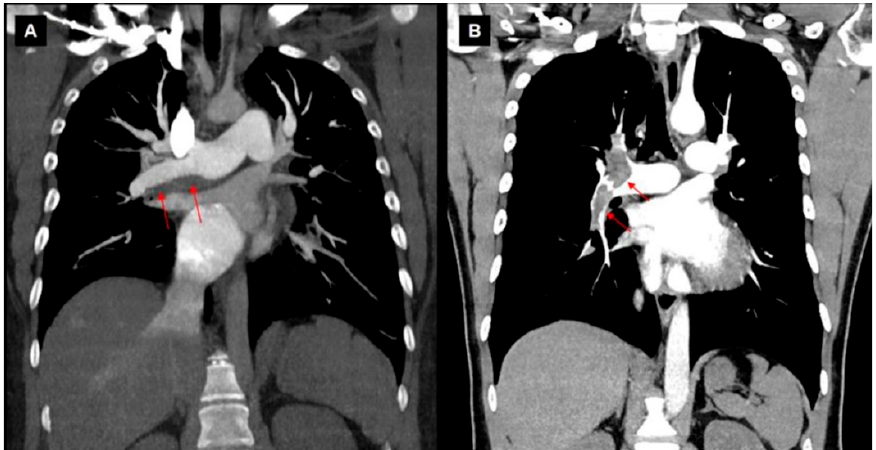
Figure 5. Distinct thrombus morphology for chronic ( A ) and acute thrombus ( B ). Note the eccentric thrombus (adhering to the vessel wall) in CTEPH ( A ); central filling defect in acute PE.